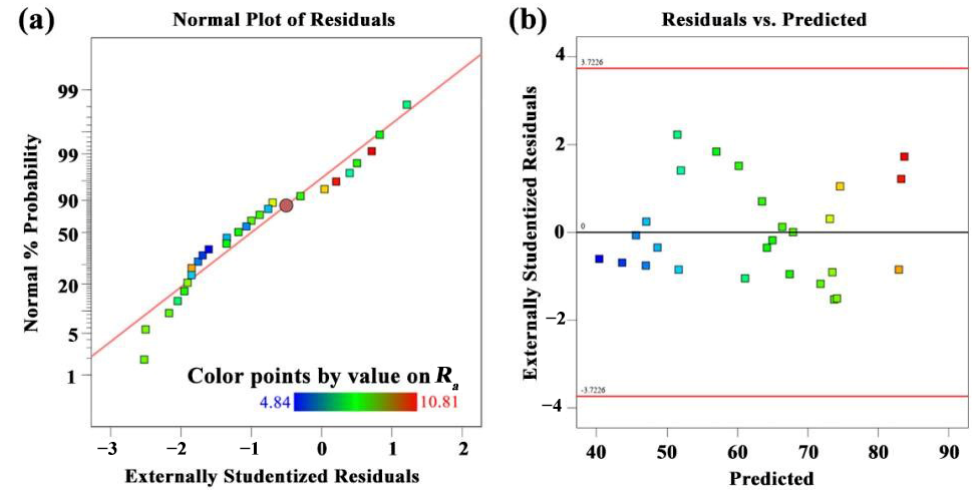
Figure 6. ( a ) Normal distribution of experimental data ( b ) predicted value with residuals.